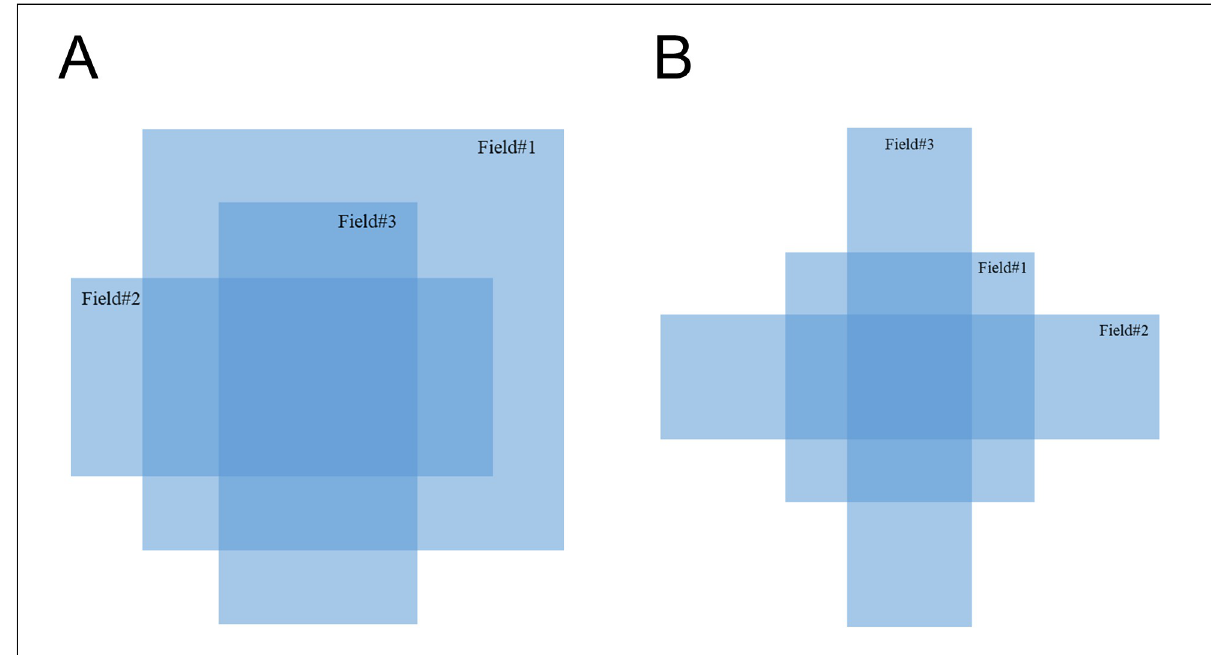
Fig 9. Simple intensity-modulated plans: (A) Field type 1 and (B) Field type 2.